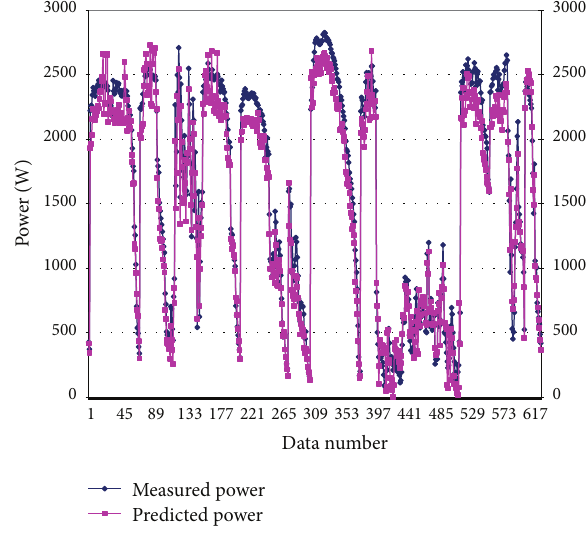
Figure 7: Output power prediction for Model #1, which selects sunny and cloudy data